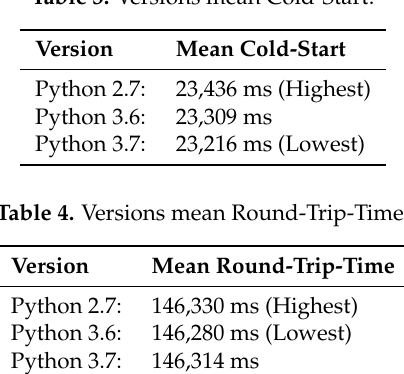
Figure 5. Scale Test results Cold-Start Memory. Table 3. Versions mean Cold-Start.